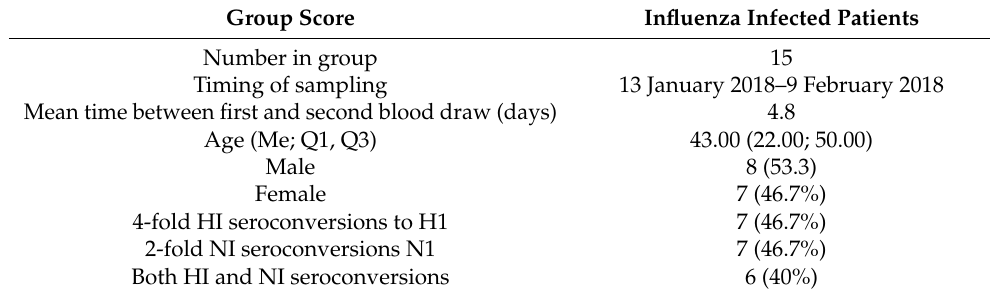
Table 1. Patient’s